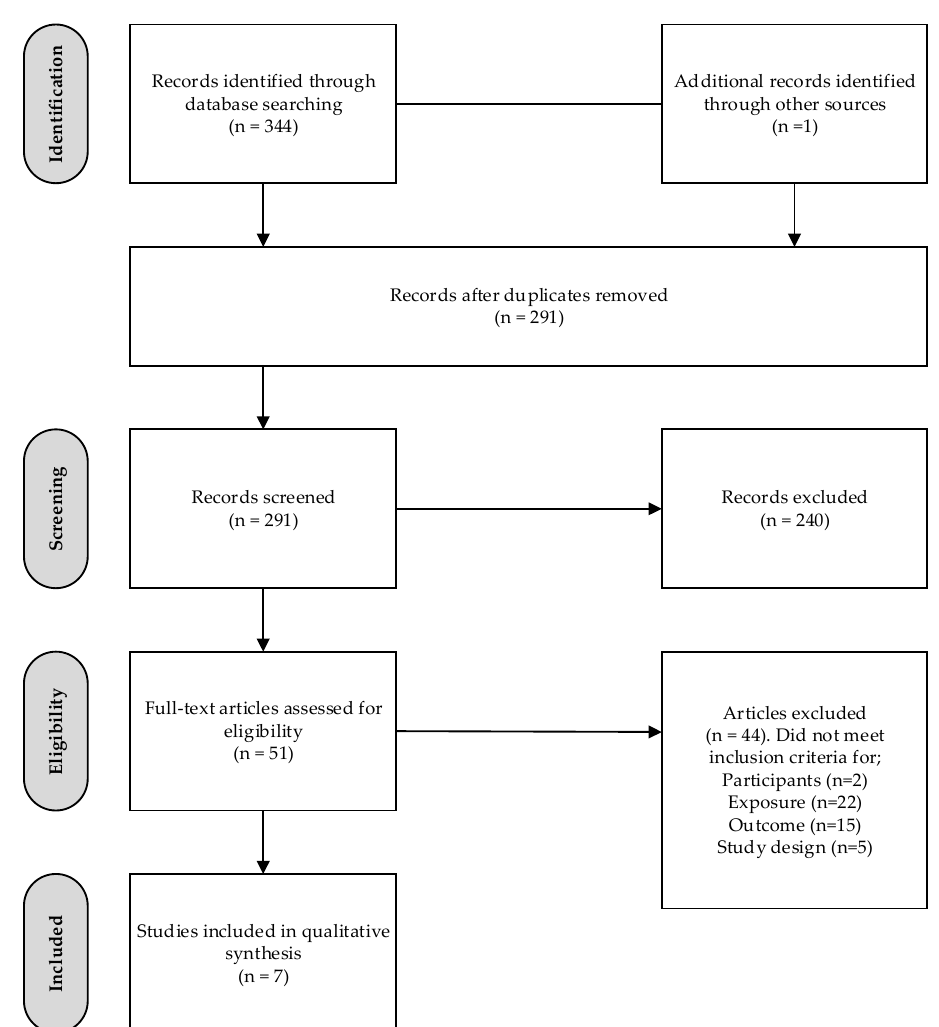
Figure 1. Dietary intake and academic achievement systematic review: Flow diagram.